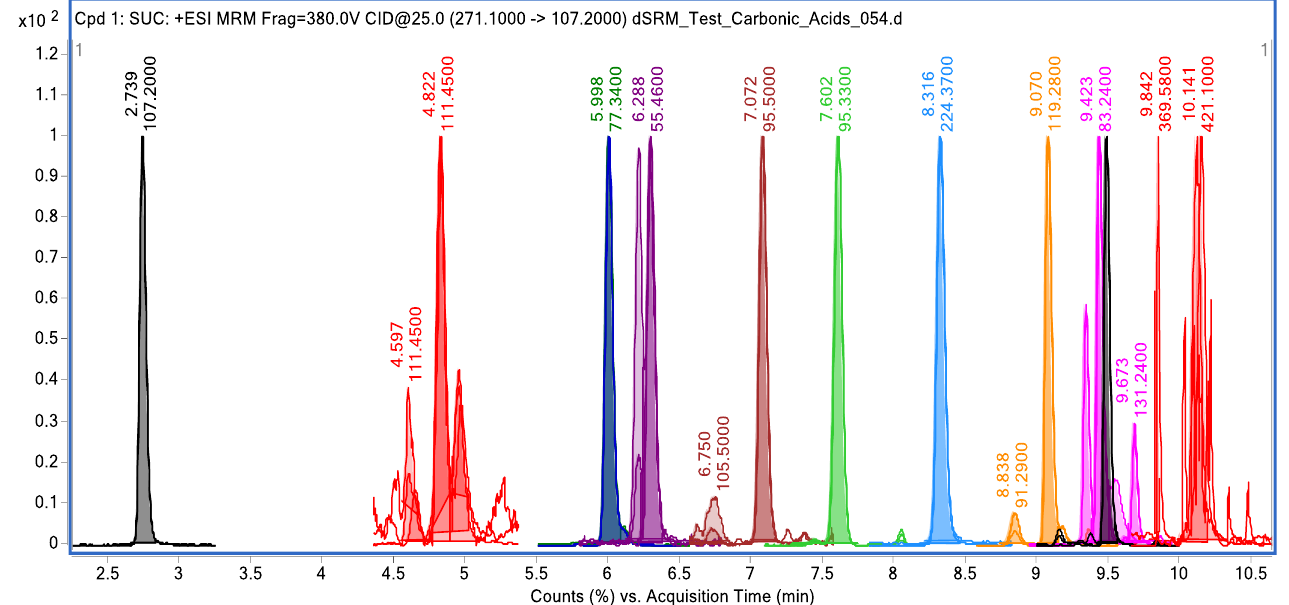
Figure 2. Chromatographic separation of derivatives of carboxylic acids. The specific retention times for each of the carboxylic acid derivatives on the column are shown in Table 8. The peak of lactic acid, in relation to which the retention time on the column was normalized, is indicated in the figure in red, with a retention time of 4.822 min. Table 9. Characteristics of the calibration curves for the analyzed carboxylic acids obtained using triple quadrupole MS. Carboxylic acids are presented in ascending order of retention time.